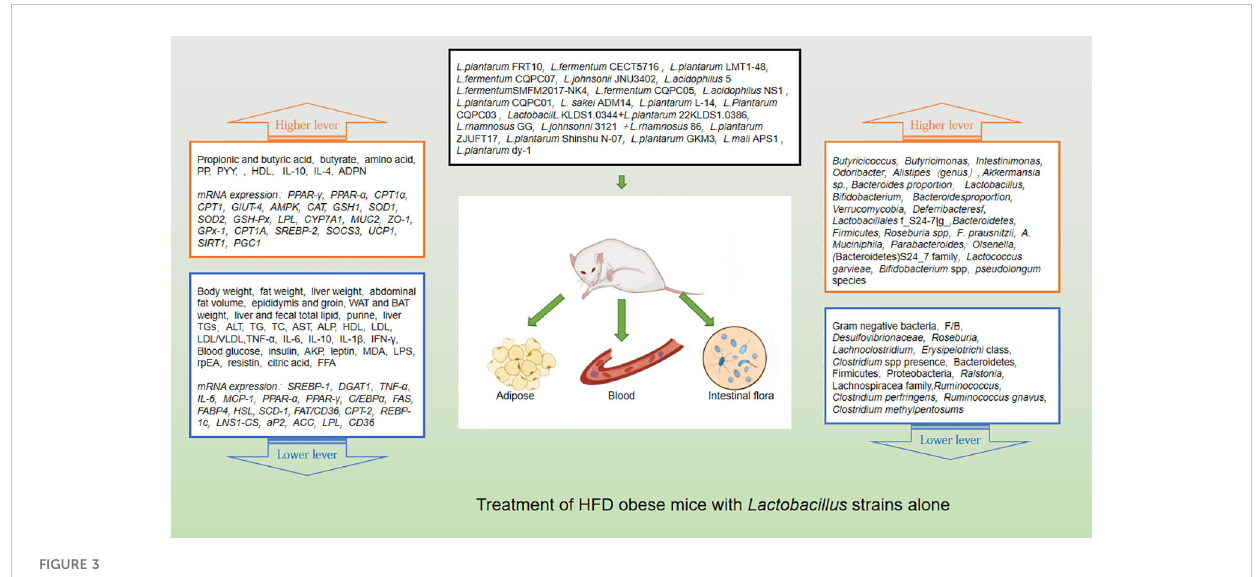
FIGURE 3 Treatment of HFD obese mice with Lactobacillus strains alone.